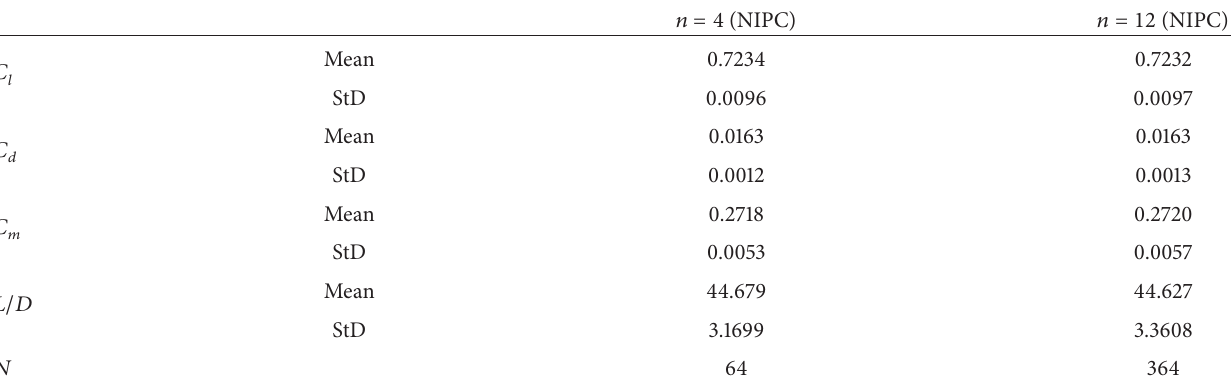
Table 4: The comparison of the UQ results for aerodynamic coefficients between the selected 4 modes and the full 12 modes.